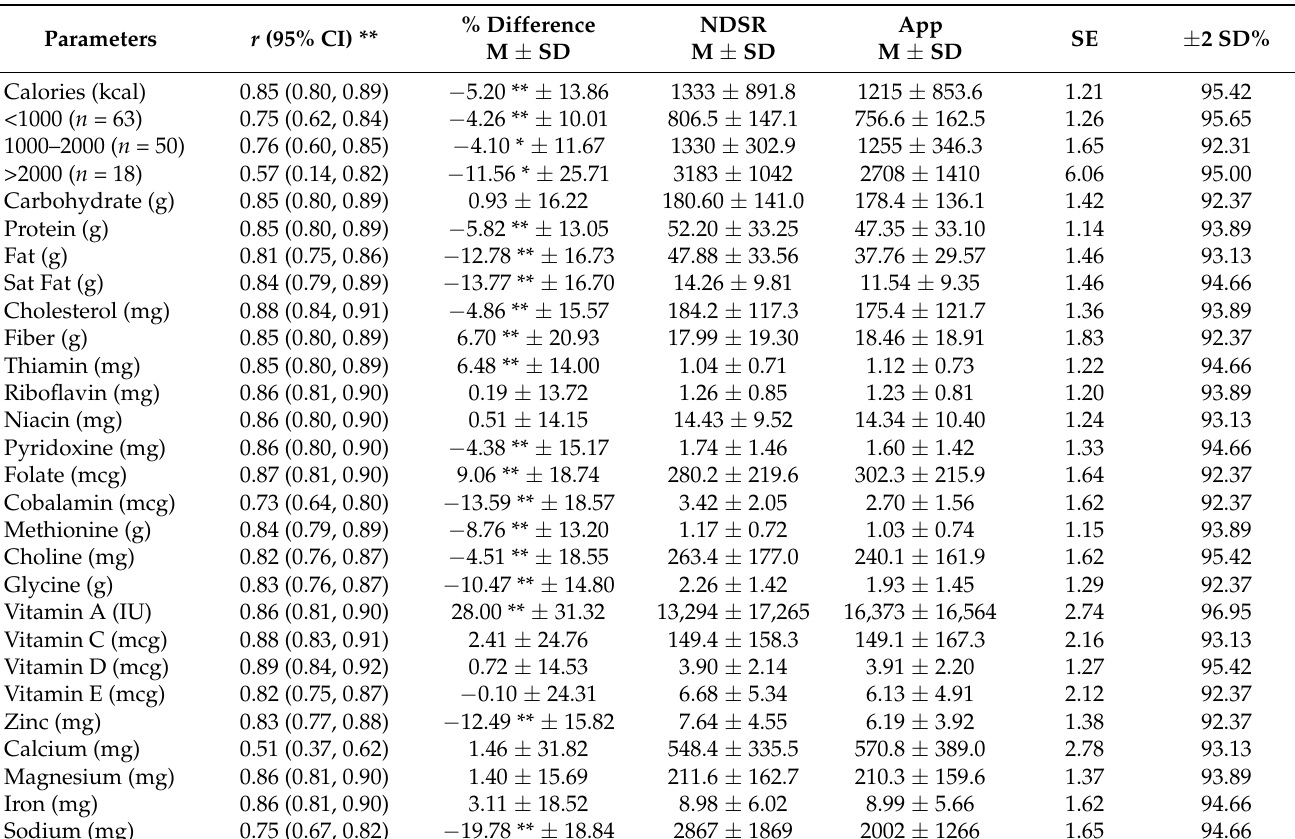
Table 1. Agreement and bias for the internet-based application (App) against Nutrition Data System for Research ( n =